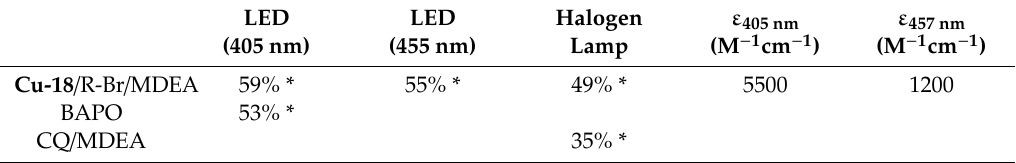
Figure 9. Chemical mechanism involved in the generation of radicals in the reductive cycle. Table 3. TMPTA conversions determined in laminate upon irradiation at different wavelengths of the three-component system Cu-18/ R-Br/MDEA (0.2%/2%/3% w / w / w ) for 500 s and light absorption properties at the emission wavelength of the light sources (extracted from the work in [80]).